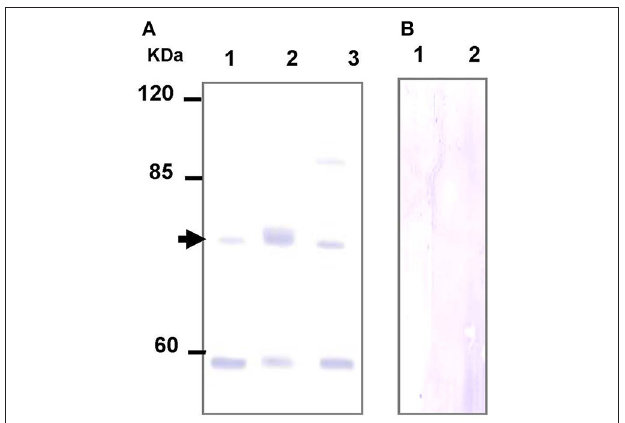
FIGURE 6 | Specificity analysis of the hard clam TAUT antibody. The protein samples were separated by SDS-PAGE gel electrophoresis and performed immunoblotting with the (A) hard clam TAUT antibody or (B) pre-immune serum. (A) The predicted band at ∼ 74 kDa could be found in the immunoblotting with the hard clam TAUT antibody. The arrow indicated the predicted immunoreactive band. Lane 1, 250 µ g protein from the washed IP solution; Lane 2, 20 µ g eluted protein from immunoprecipitation with TAUT antibody; Lane 3, 100 µ g protein form the gill homogenate. (B) The pre-immune serum was used as the negative control, which revealed no immunoreactive band. Lane 1 and 2, 100 and 200 µ g protein form the gill homogenate, respectively.